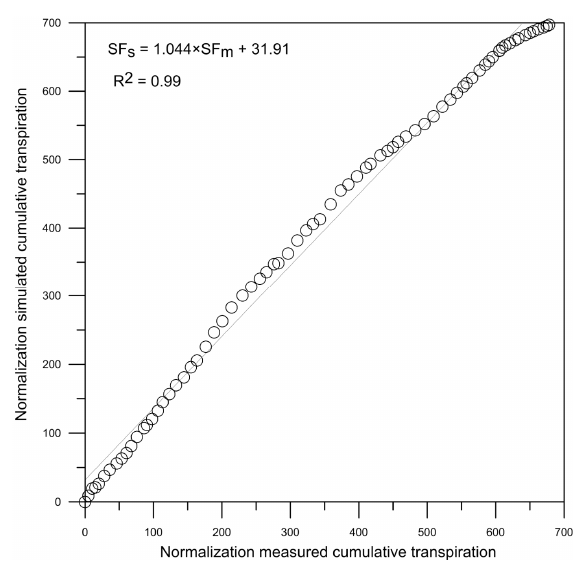
Figure 4. The fit of measured soil water content at eight different depths based on soil profile (points) using model-computed values (solid lines) for the calibration period (26 April to 12 July) and the validation period (13 July to 27 September).